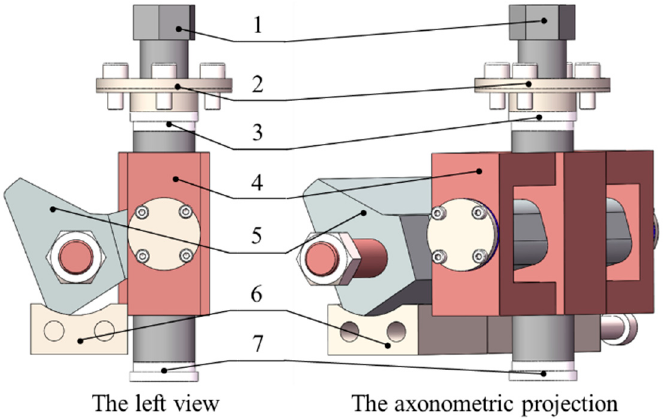
Figure 2. Thread fastening system. 1—Fastening bolt, 2—Bearing cap, 3—Bearing, 4—Shift forks, 5—Clamping block, 6—Cushion block, 7—Bearing. 5—Clamping block, 6—Cushion block,